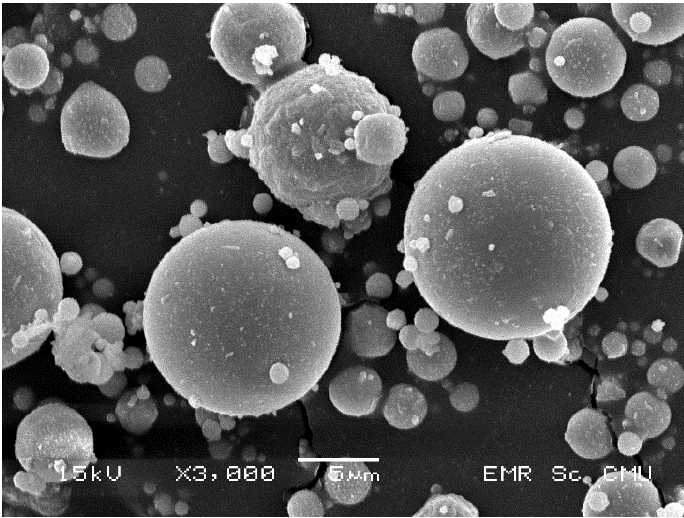
Figure 2. The SEM images of the FA in this study. Table 1. Chemical compositions of the raw materials. Chemical Composition